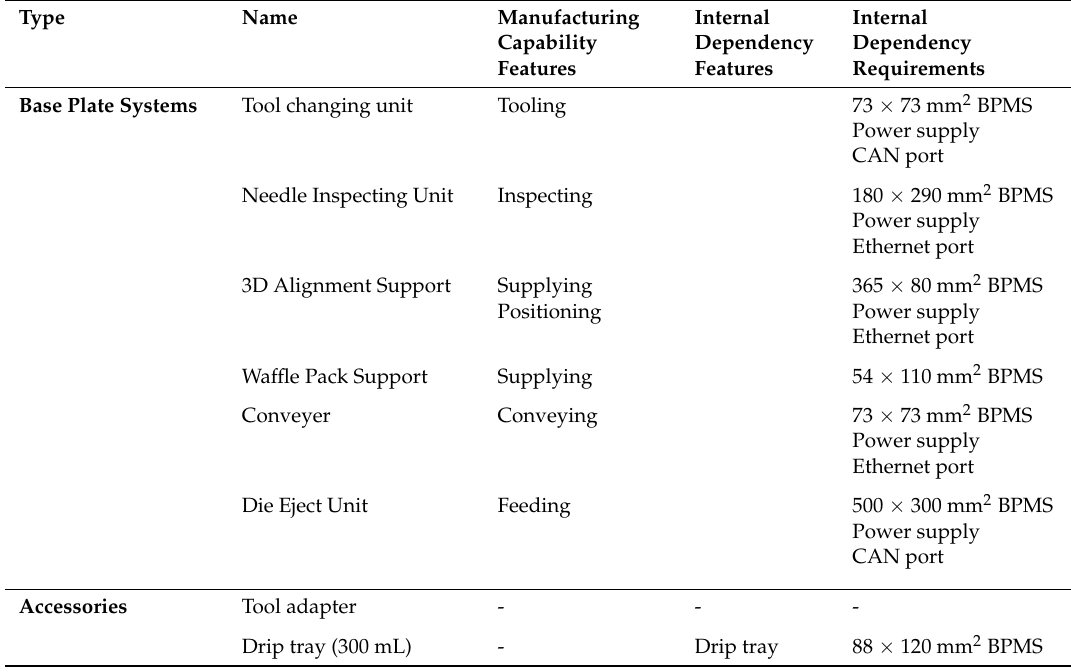
Table 9. Base plate systems and accessories used for